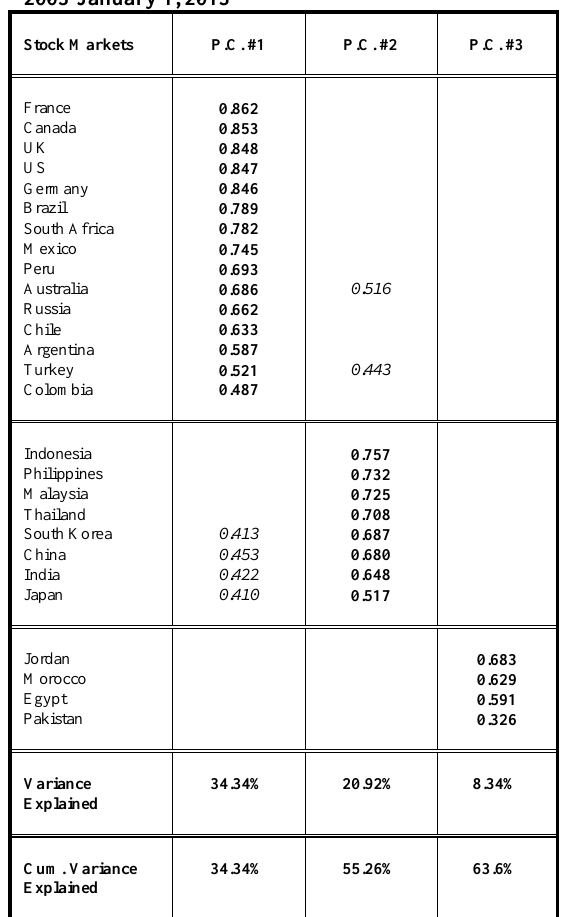
Table 2: Principle Components Analysis: January